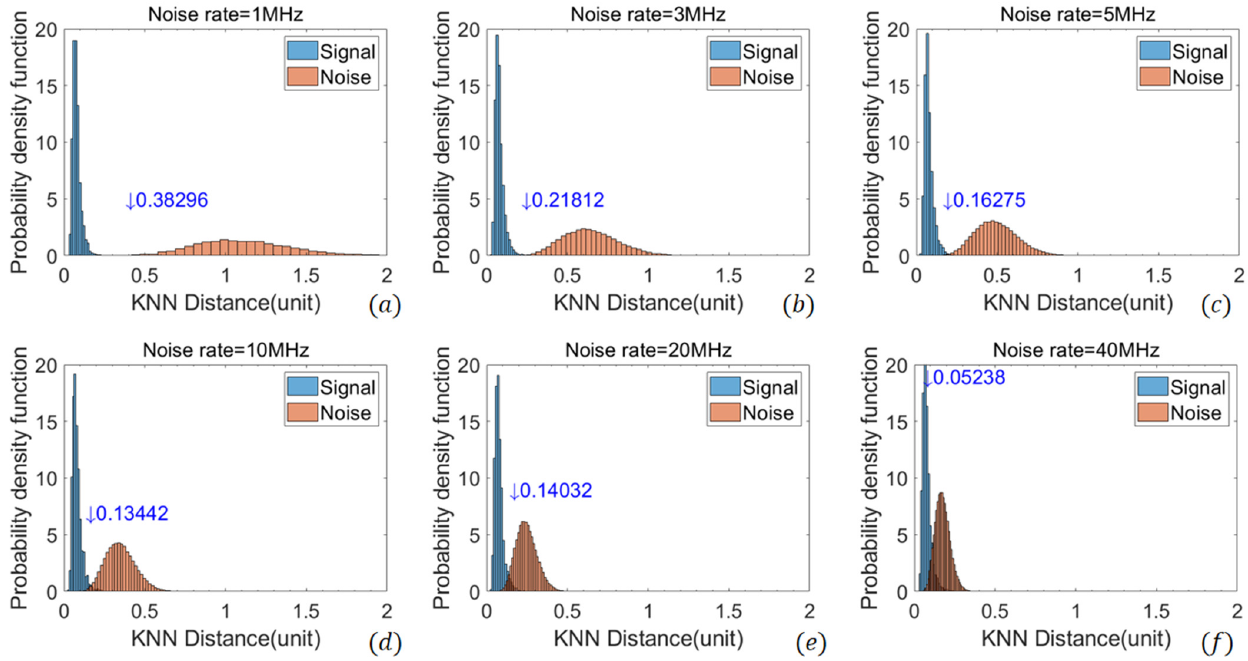
Figure 11. Distribution of signal and noise histograms ( p = 0.55). ( a ) Background photon count rate is 1 MHz. ( b ) Background photon count rate is 3 MHz. ( c ) Background photon count rate is 5 MHz. ( d ) Background photon count rate is 10 MHz. ( e ) Background photon count rate is 20 MHz. ( f ) Background photon count rate is 40 MHz.